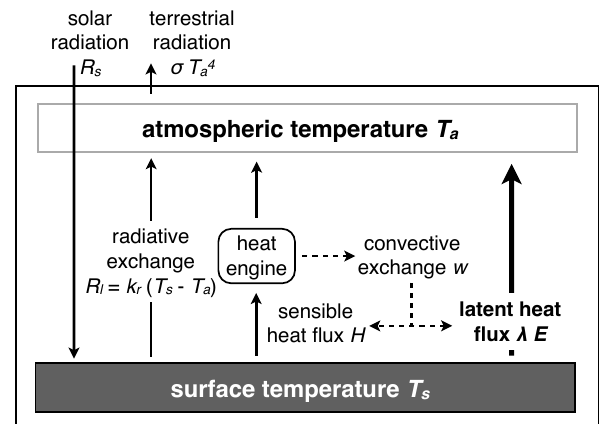
Fig. 1. Schematic illustration of the simple energy balance model that is used to describe the strength of the hydrologic cycle through the rate of surface evaporation, E , with the main variables and fluxes used here. After Kleidon and Renner